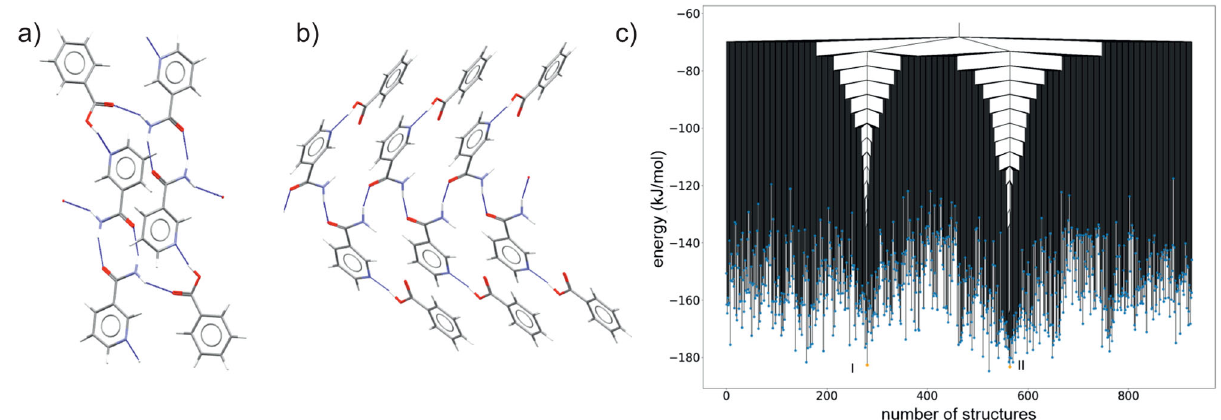
Fig. 4 Structures and disconnectivity graph of the nicotinamide:benzoic acid co-crystal. Hydrogen bonding in polymorphs a I and b II of the nicotinamide:benzoic acid co-crystal. Carbon atoms are grey, oxygen red, nitrogen blue and hydrogen white. Hydrogen bonds are shown as dashed blue lines. c Disconnectivity graph from threshold simulations for the 1:1 nicotinamide:benzoic acid co-crystal in space group P 2 1 / c . The horizontal axis labels the number of structures located during the threshold simulation. The order of structures is chosen to group together structures separated by low energy barriers. A disconnectivity graph showing the entire sampled energy range is shown in Supplementary Fig.